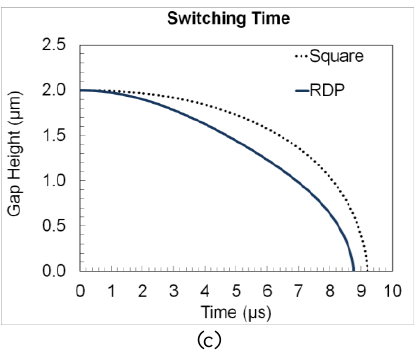
Figure 7. (a) Comparison of the actuation-voltage shift between square and RDP. (b) C/V curve shift by square and RDP actuation voltage. (c) Effects of the actuation signal waveform on the switching